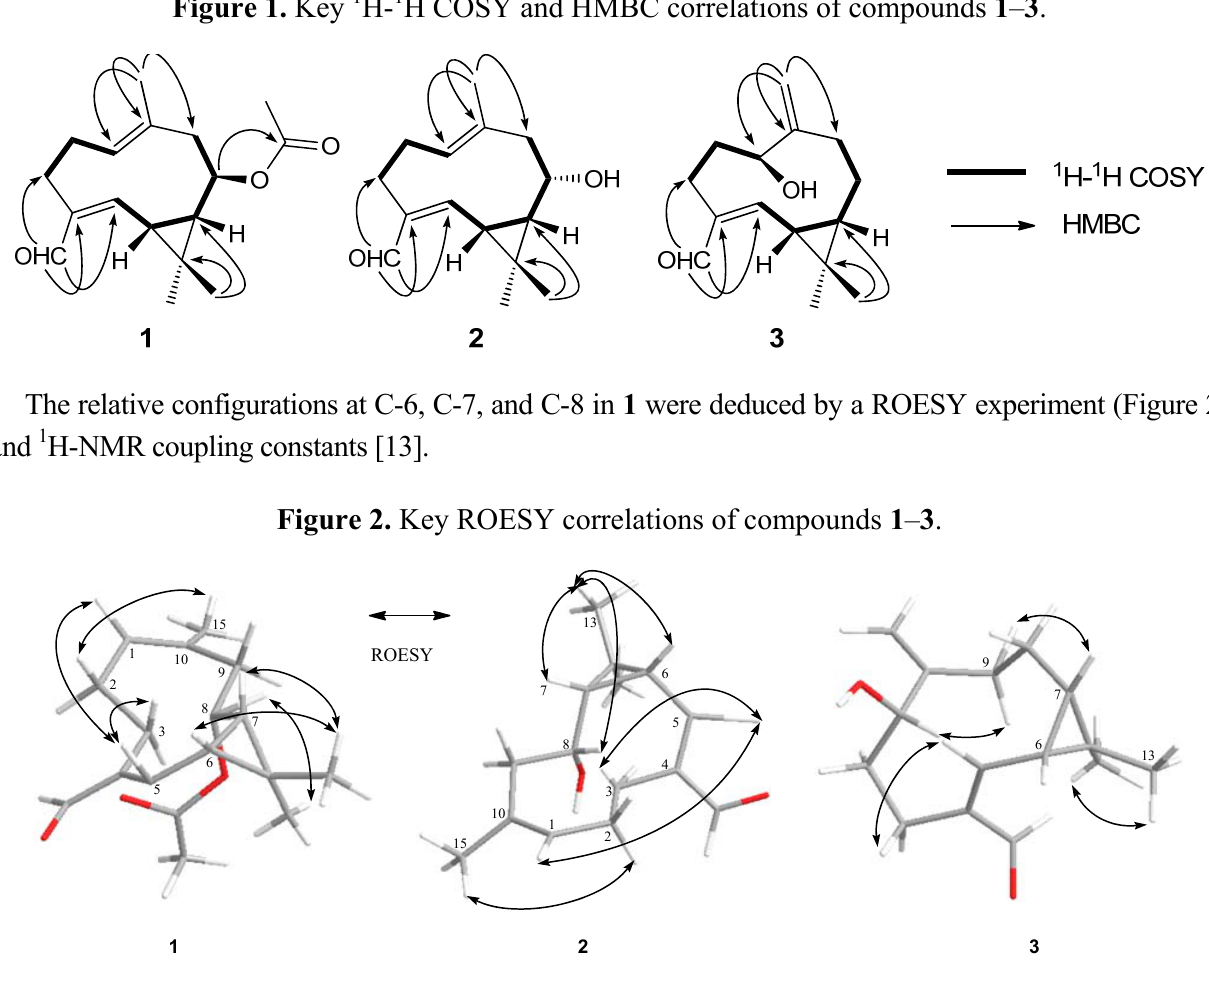
Figure 1. Key 1 H- 1 H COSY and HMBC correlations of compounds 1 – 3 .